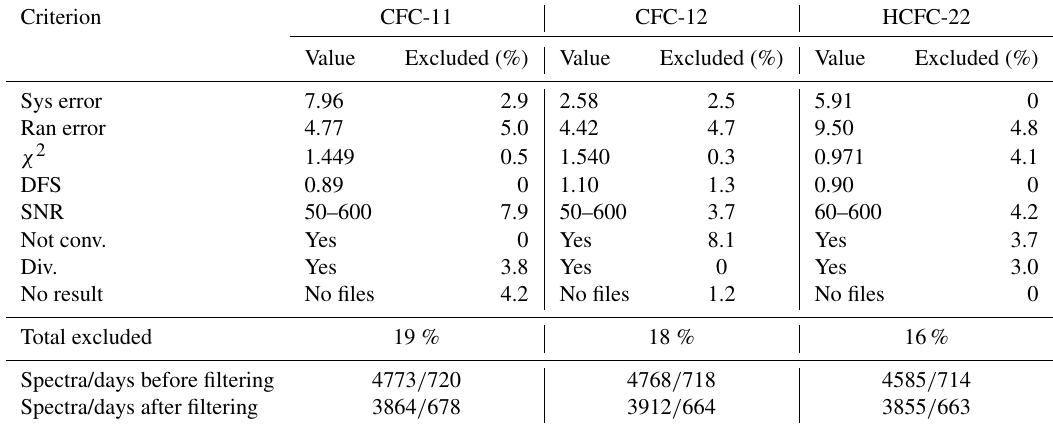
Table B1. The criteria used and the percentage of data discarded after their